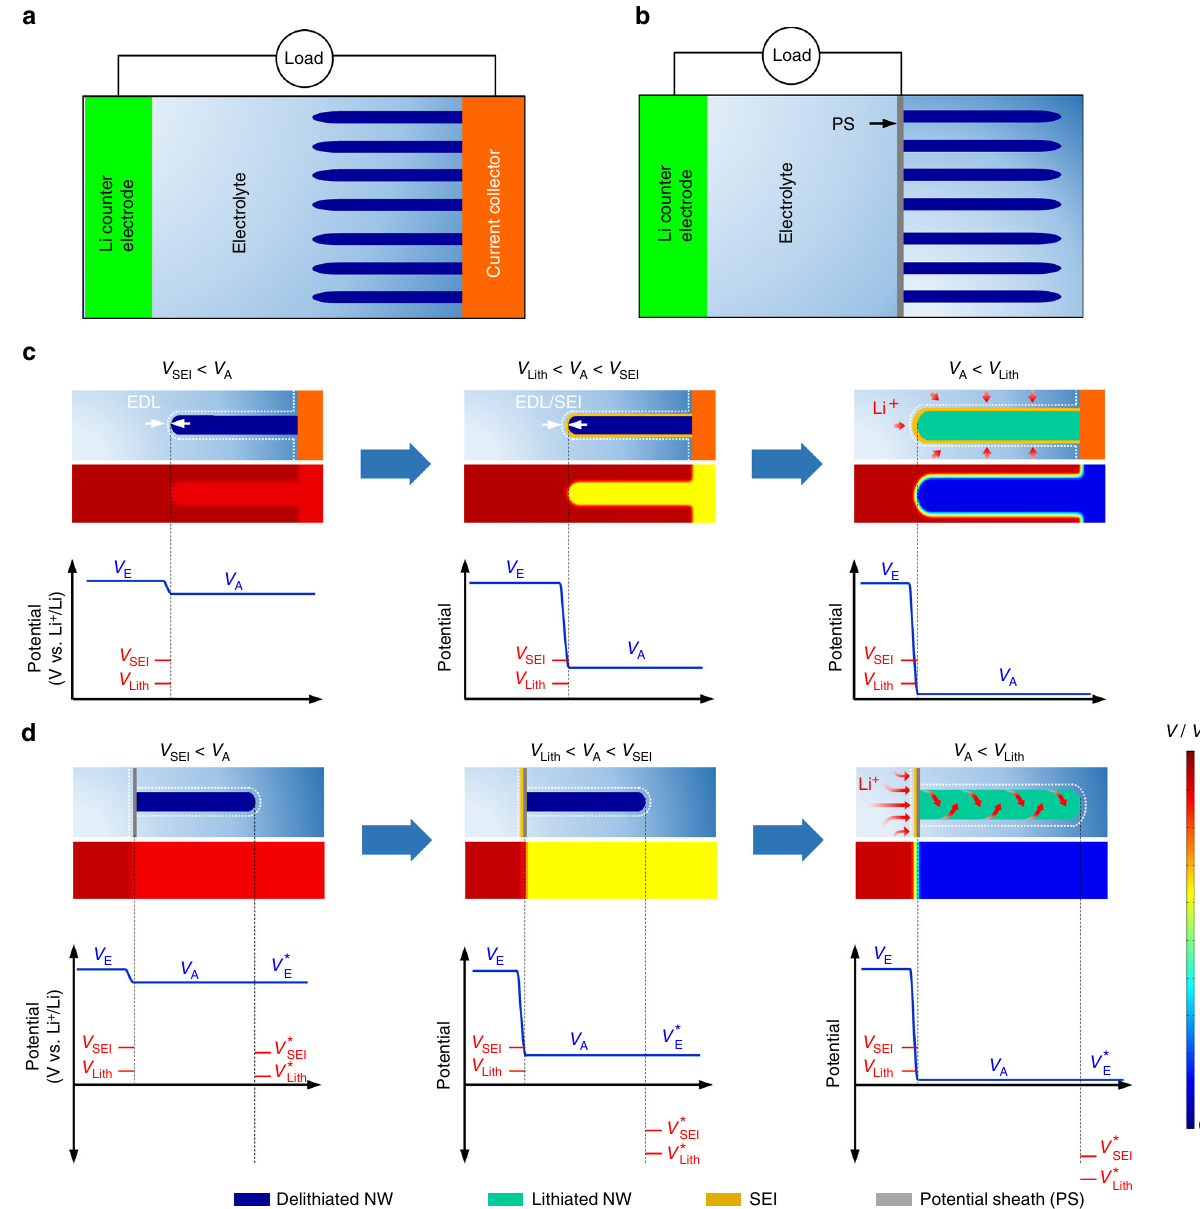
Fig. 1 Schematic and electrical potential pro fi les of the NW-based anodes. a , b Schematics of a half-cell with a general NW anode on a current collector ( a ) and a half-cell with an NW anode enclosed by PS ( b ) paired with counter electrodes. An external load drives the NW anode to become lithiated. c Schematics and corresponding FEA simulation results of electrical potential pro fi les across the electrolyte and NW anode for the case in a , during the fi rst charging cycle. SEI formation and lithiation start at a potential below the V SEI and the V Lith , respectively. d Schematic and corresponding electrical potential pro fi les across the outer electrolyte, electrode (PS, NW anode), and inner electrolyte for the case in b during the fi rst charging. Inside the space enclosed by the PS, the potentials across the electrode and electrolyte became nearly equivalent, thereby suppressing SEI formation on the NW surface and lithiation at the electrolyte and NW